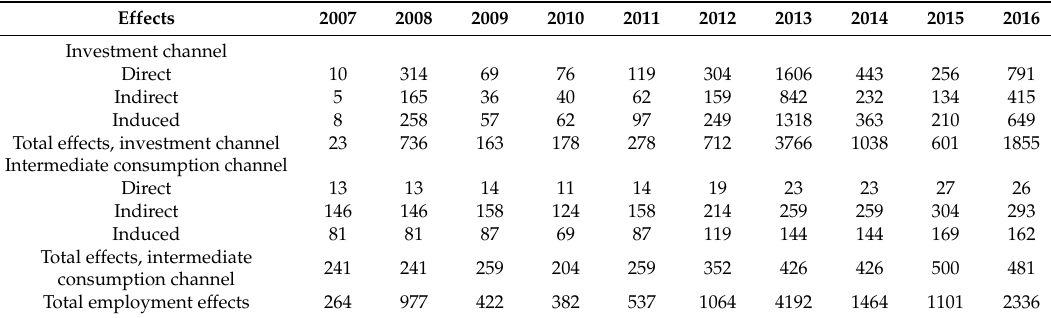
Table 5. Total full time equivalent (FTE) employment induced by wind power plants deployment and operation in Croatia, in terms of annual labor